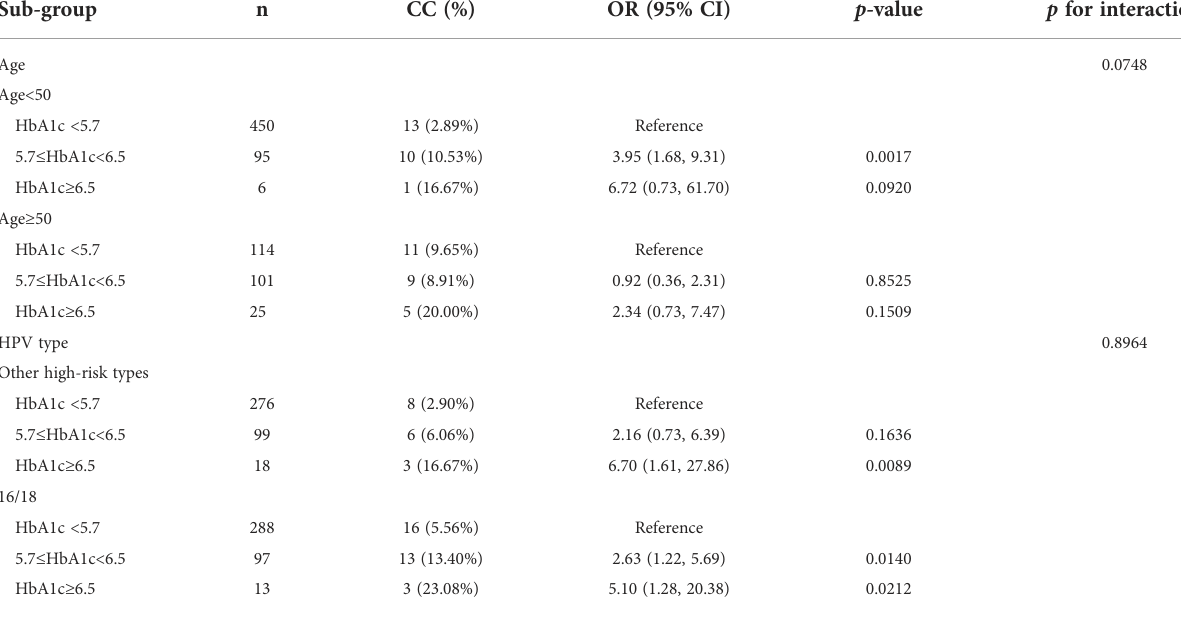
TABLE 3 Subgroup analysis of the association between HbA1c on cervical carcinoma.